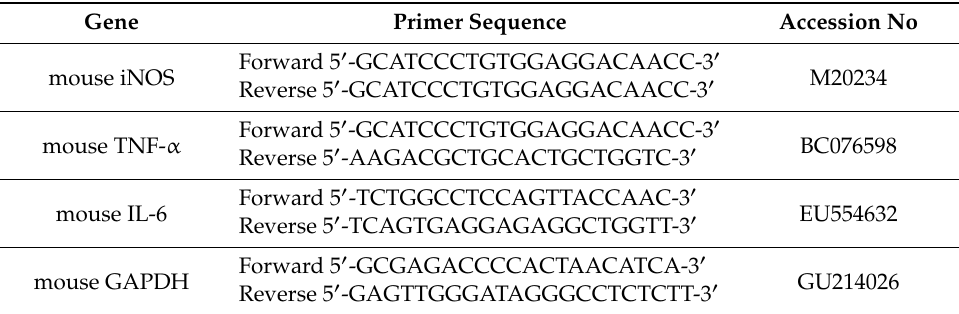
Table 2. List of primers used in this